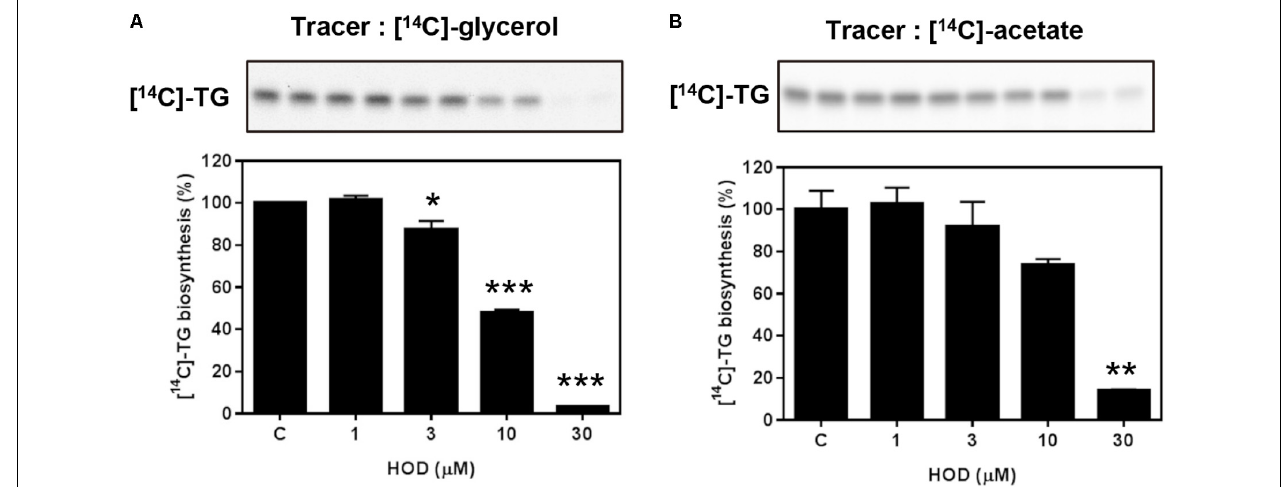
FIGURE 2 | Inhibitory effect of HOD on de novo TG biosynthesis. HepG2 cells (5 × 10 5 cells/ml) were exposed to HOD with various concentrations in the presence of [ 14 C]-glycerol for 6 h (A) or [ 14 C]-acetate for 2 h (B) . Newly synthesized intracellular [ 14 C]-lipids were extracted and the radioactivity of TG bands were quantified by densitometry using the Multi-Gauge V3 program (Fuji Photo Film Co.). Values are expressed as percentages of control and are means ± SD of the three replicates. Significance: ∗ p < 0.05; ∗∗ p < 0.01; ∗∗∗ p < 0.001 vs. control.